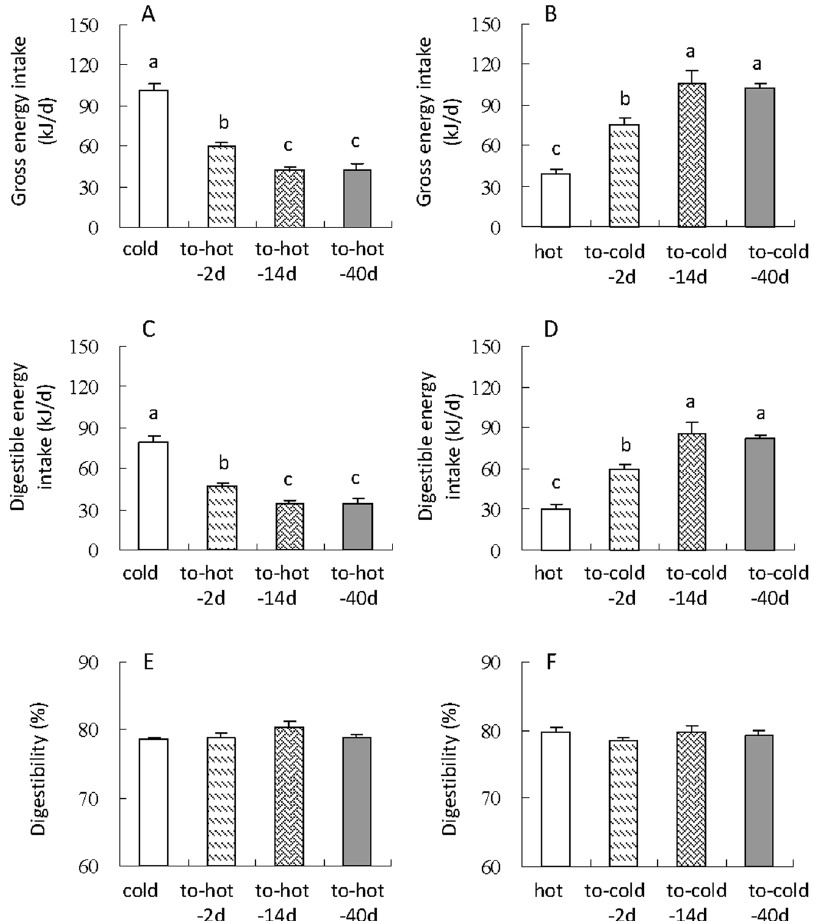
Figure 5. Gross energy intake (A, B), digestible energy intake (C, D) and digestibility (E, F) of striped hamsters during the transition of cold to hot or hot to cold condition. Different letters (a, b or c) above the columns indicate significant difference between the four groups under same temperature ( P , 0.05). Data are means 6 s.e.m.